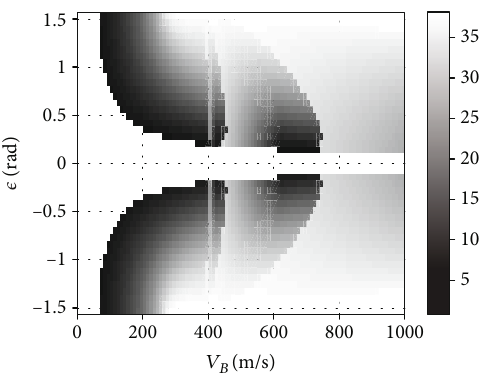
as a function of v L C